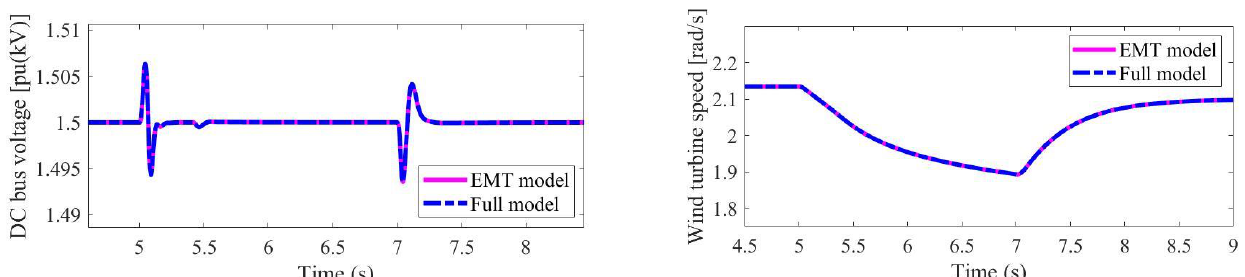
Figure 3. Grid frequency disturbance: full model vs. EMT model.